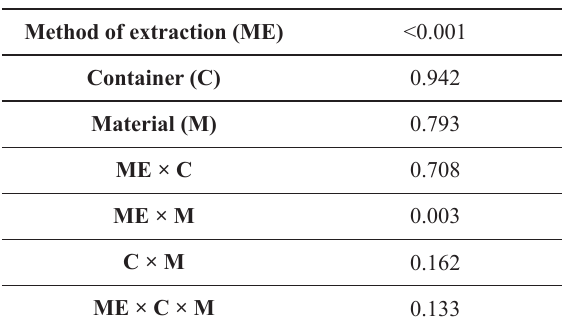
Descriptive level of probability for type I error associated with the differences between materials within each method.